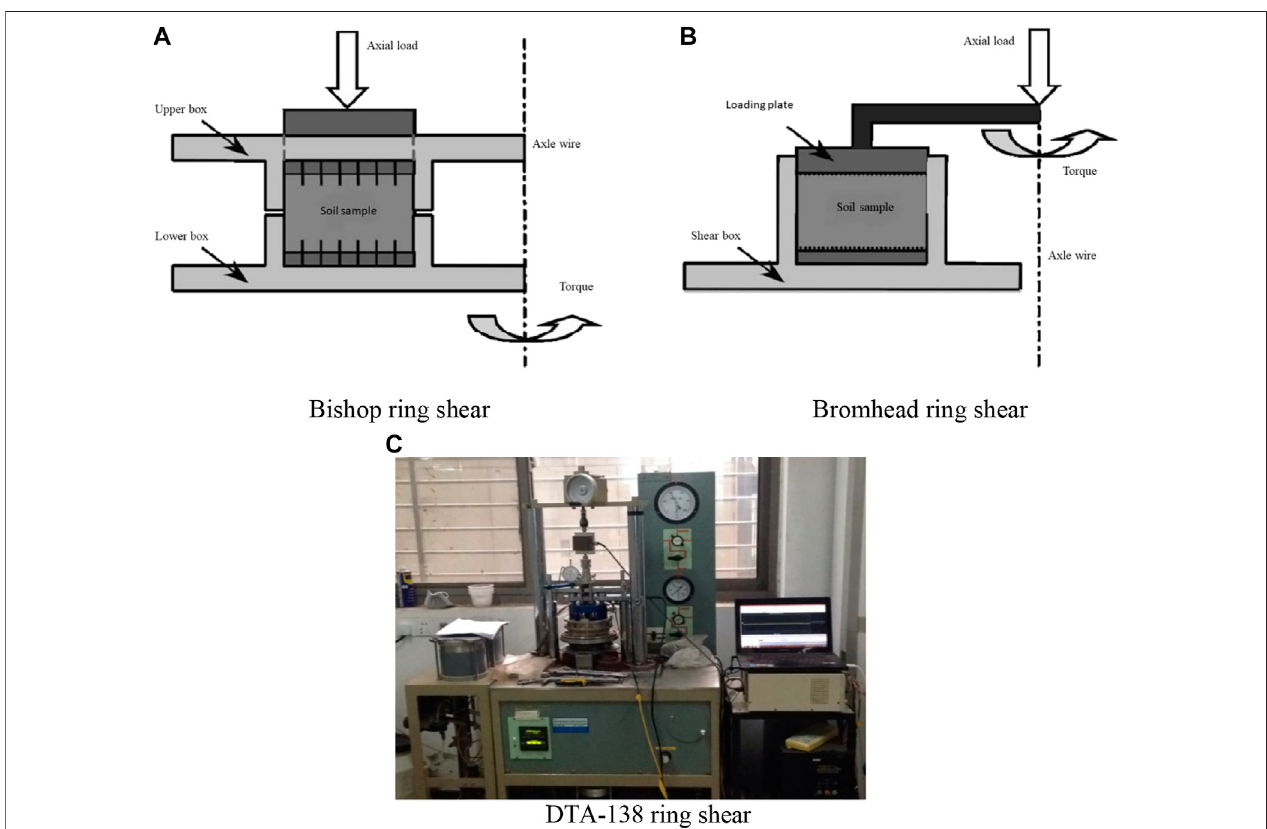
FIGURE 7 | Testing equipment. (A) Bishop ring shear. (B) Bromhead ring shear. (C) DTA-138 ring shear.